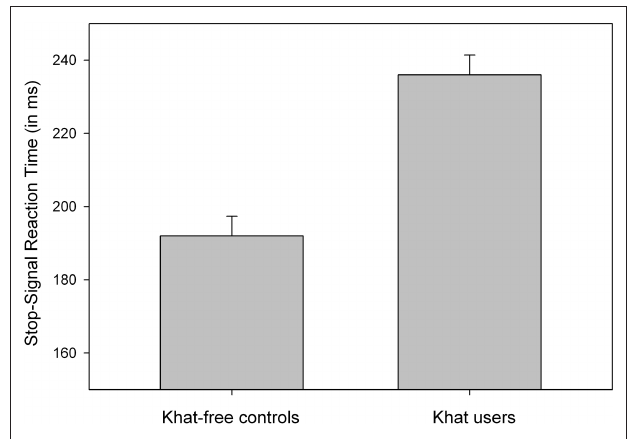
FiguRe 2 | Mean SSRT (stopping latency) as a function of group (khat-free controls vs. khat users). Vertical capped lines atop bars indicate standard error of the